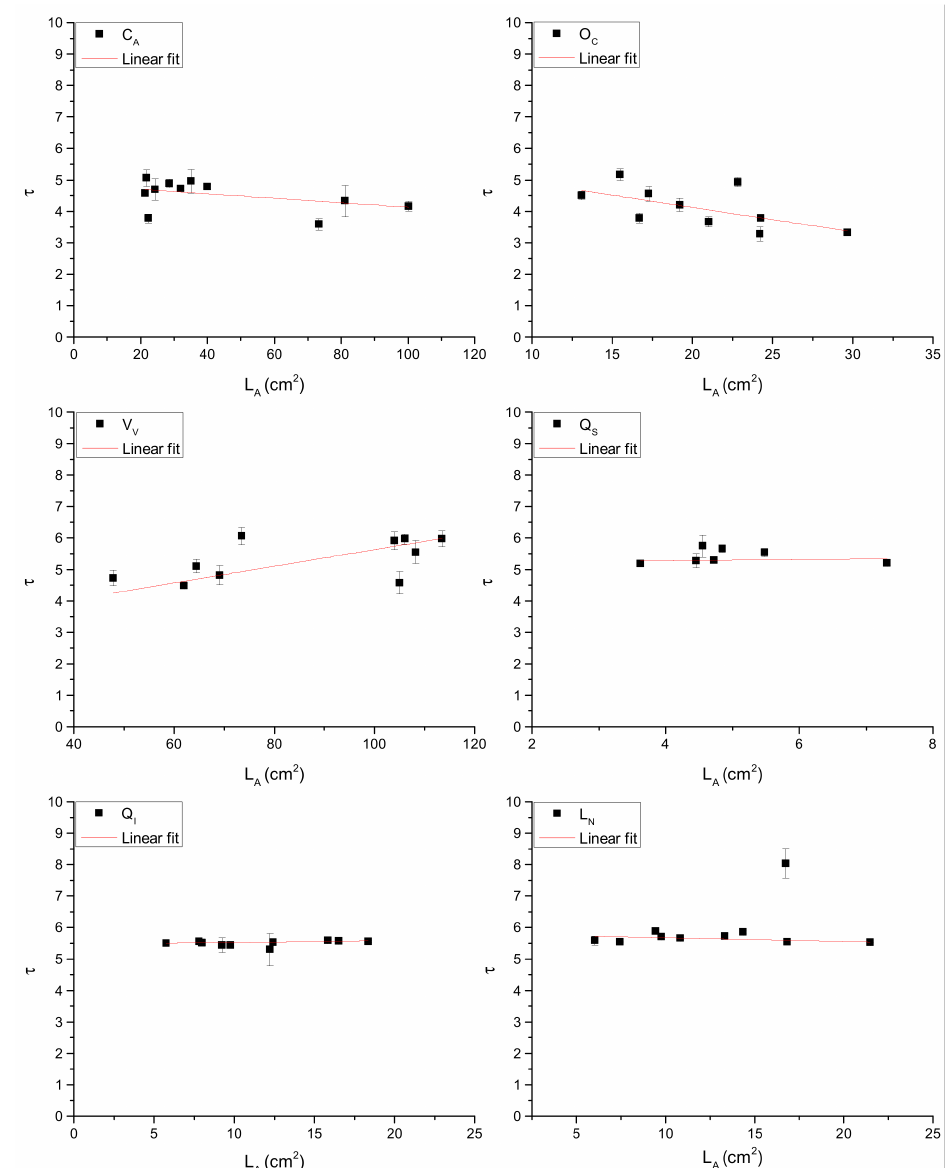
Figure 4. Relationships between τ and L A with respect to the investigated